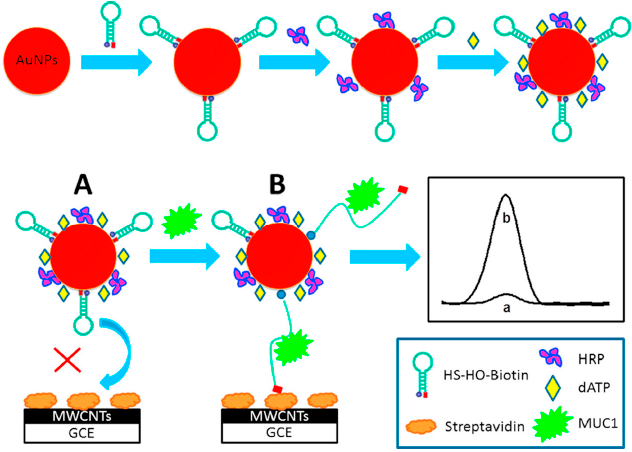
Figure 16. The scheme of MUC1 detection with the HO switch. ( A ) The biotin is shielded and thus inaccessible to the streptavidin in the absence of MUC1. Then, a very limited background current (inset) was observed (curve a). ( B ) The disruption of the stem-loop makes the biotin exposed upon target binding. Then, the biotin along with the dually labelled aptamers is easily captured by the streptavidin-modified electrode (curve b) [129]. Copyright 2013. Reproduced with permission from Elsevier B.V.